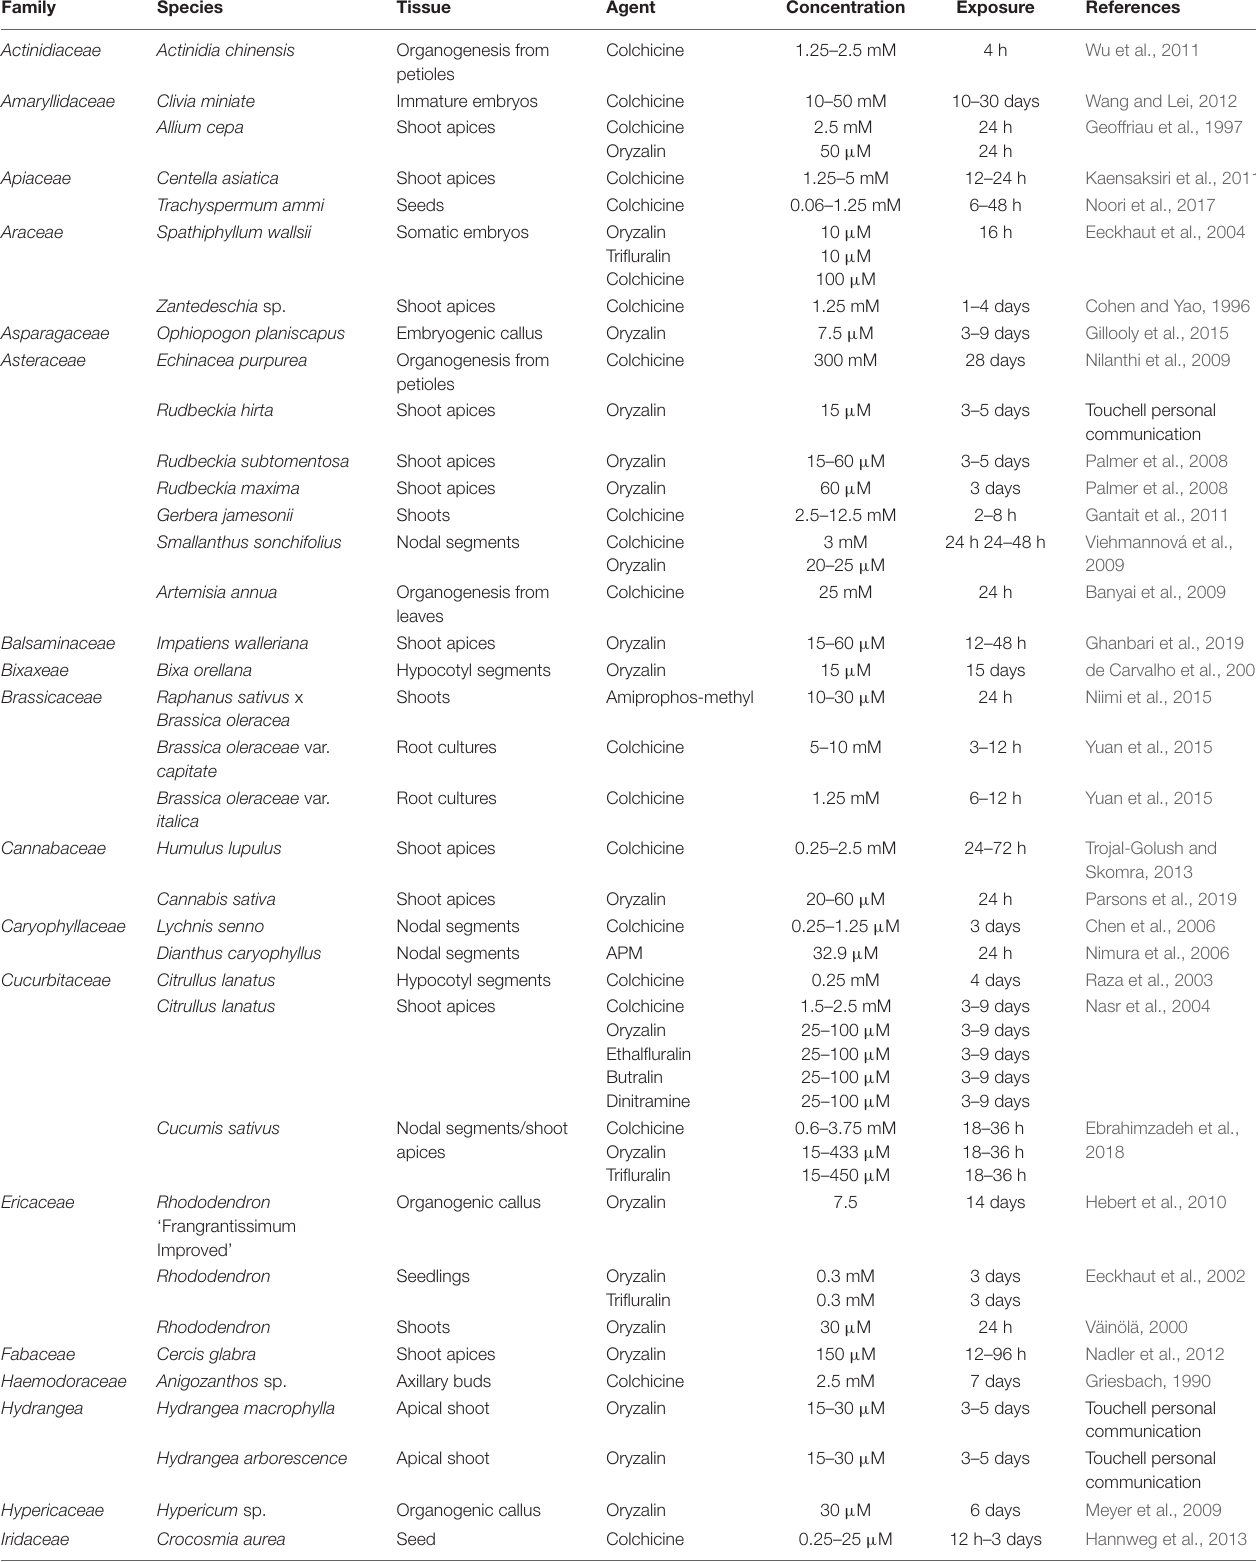
TABLE 1 | Reported in vitro polyploid induction of diverse crops utilizing varied tissues, antimitotic agents and concentrations, and exposure